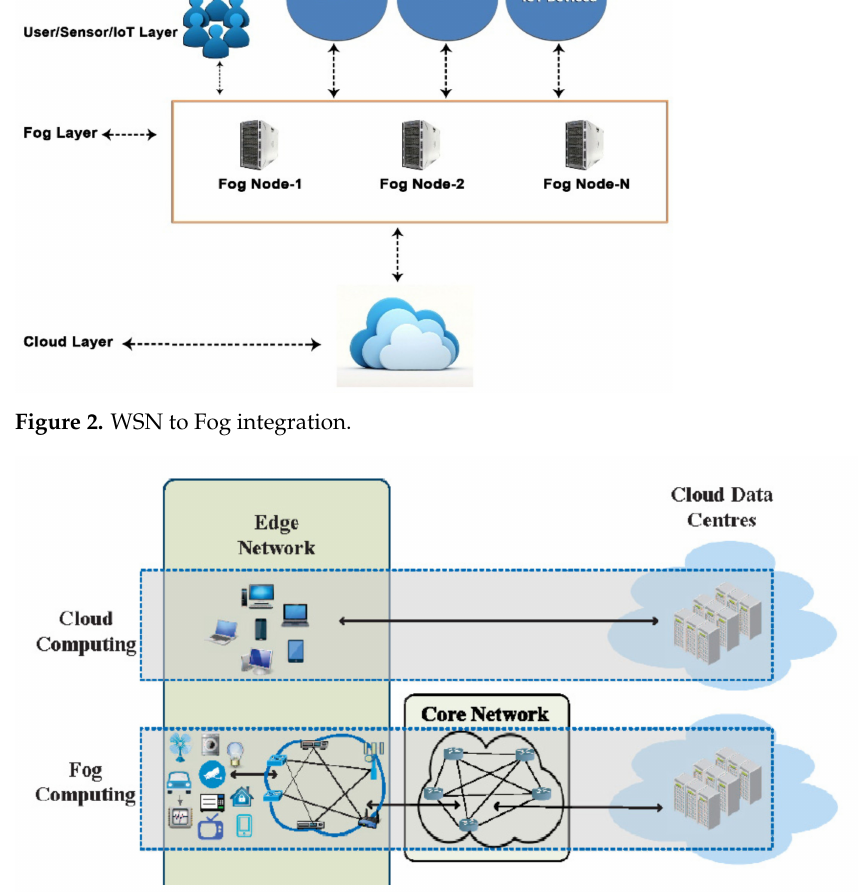
Figure 3. Fog computing vs cloud computing